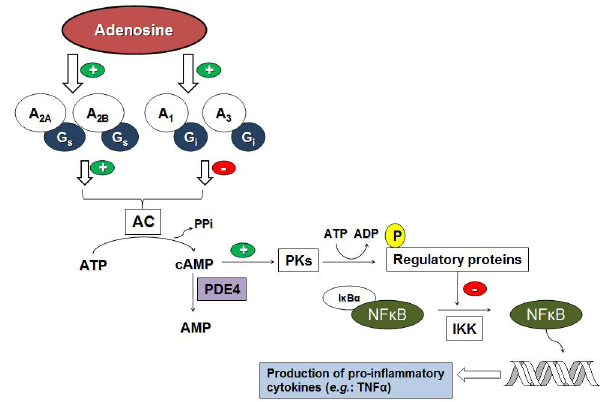
FIGURE 4 - Biology of cAMP and its role in the modulation of inflammatory